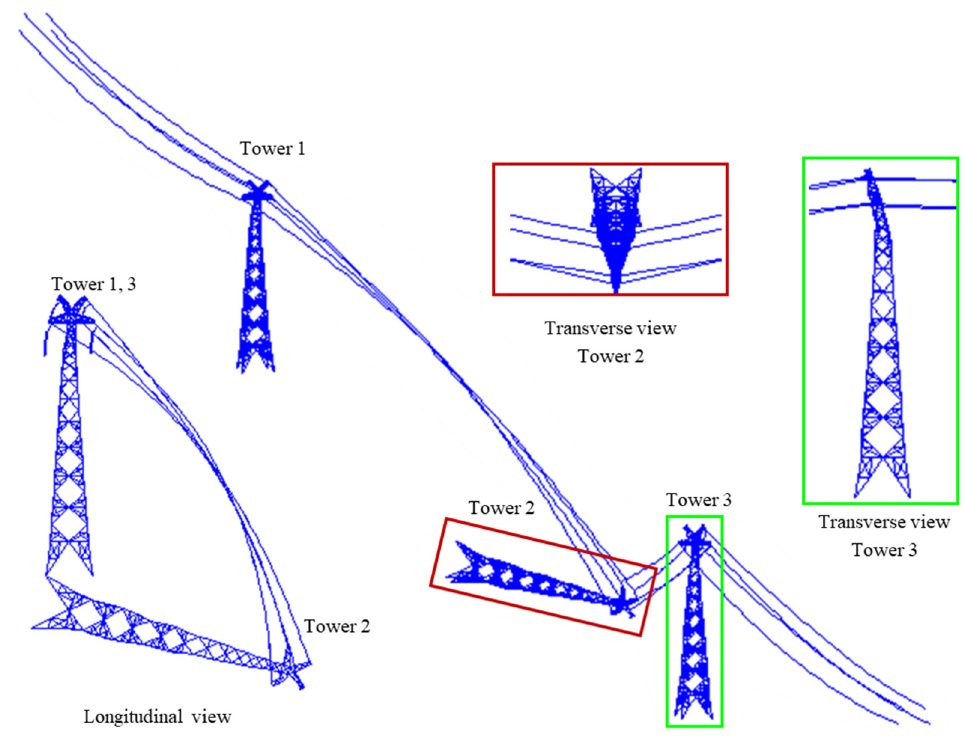
Figure 14. Behavior of the transmission tower-line structure at t = 14.3 s under Case 1.